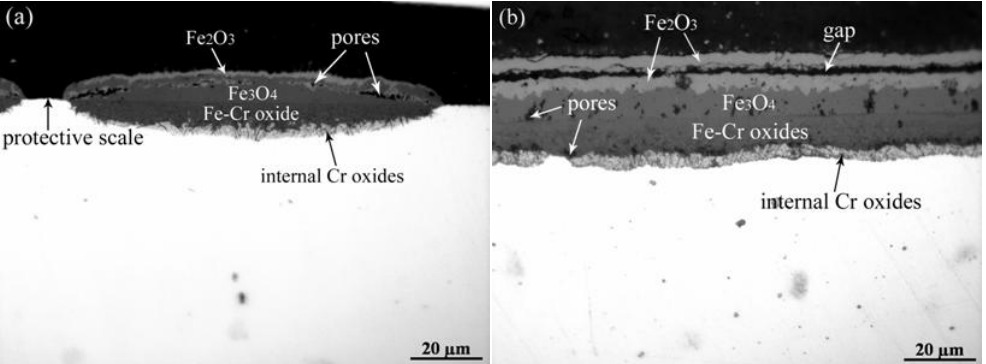
then H O; and ( b ) H O then O 2 2 2 2